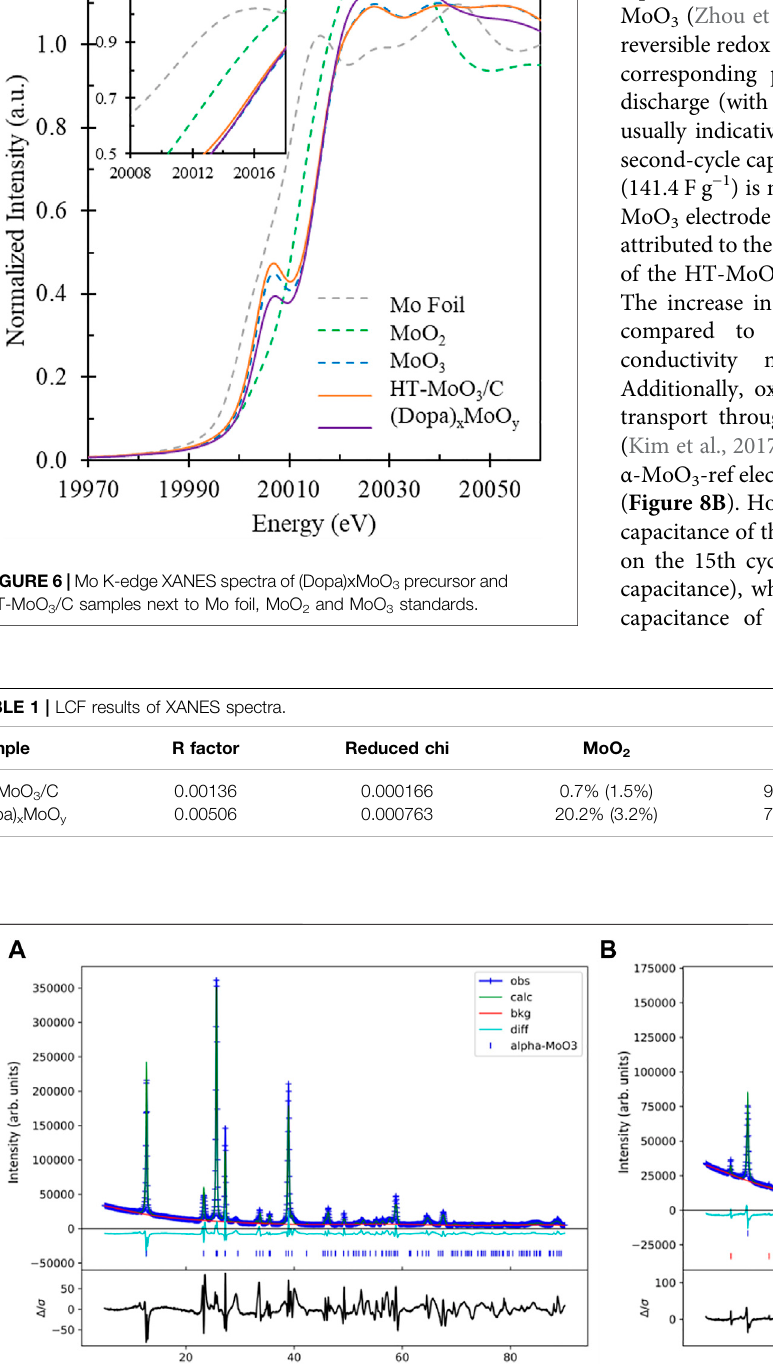
FIGURE 7 | Rietveld re fi nement of the XRD patterns collected for (A) α -MoO 3 -ref and (B) HT-MoO 3 /C samples.